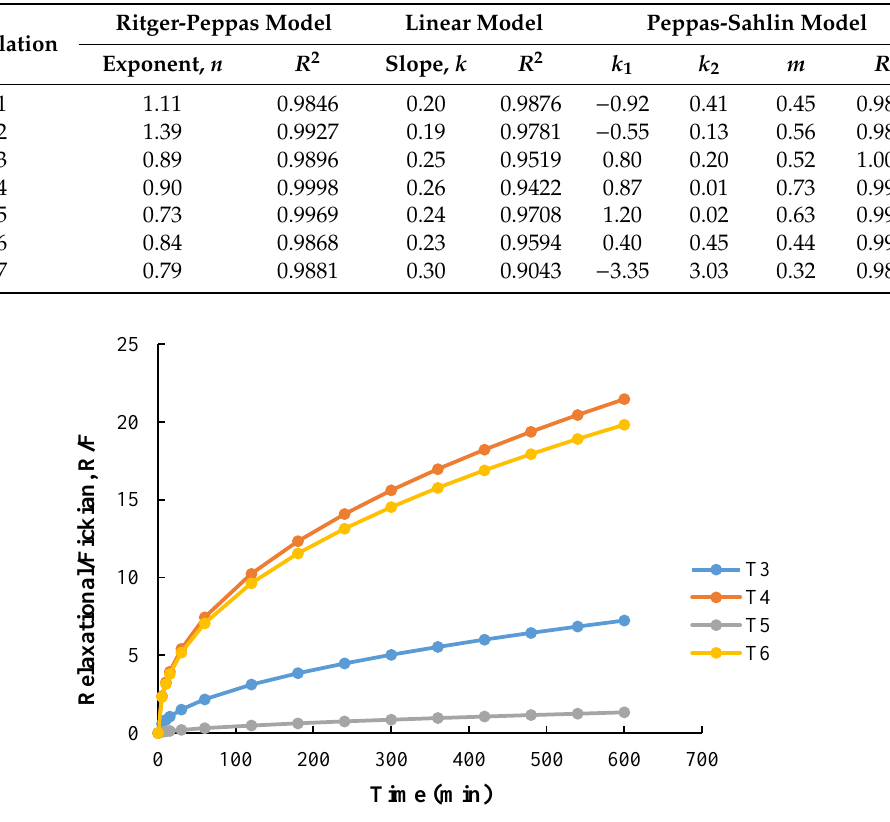
Figure 7. Swelling contribution (R) to the diffusion contribution (F), R/F ratio from T3, T4, T5, and T6.